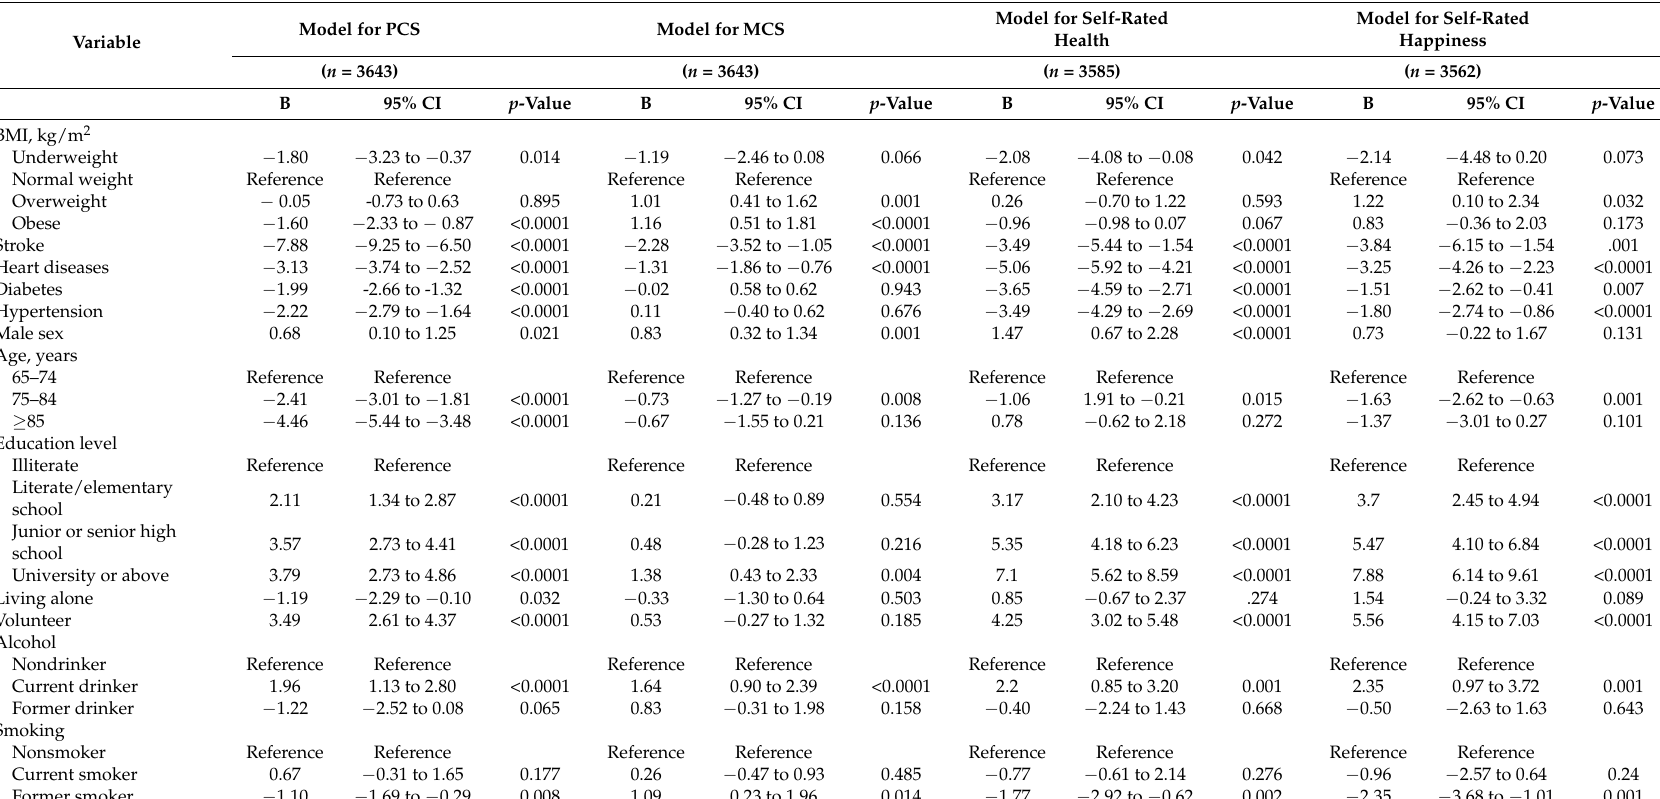
Table 4. Unadjusted Analysis of Associations between Independent Variables and Scores of PCS, MCS, Self-rated Health and Self-rated